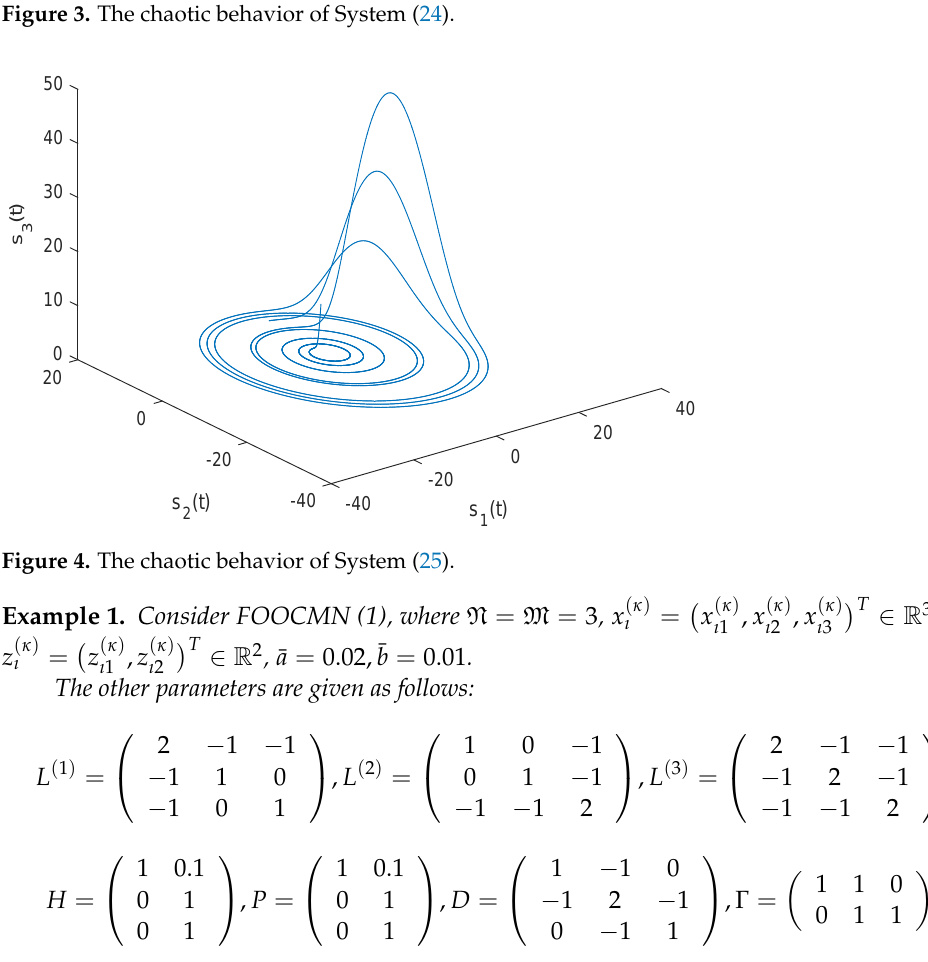
Figure 3. The chaotic behavior of System (24).